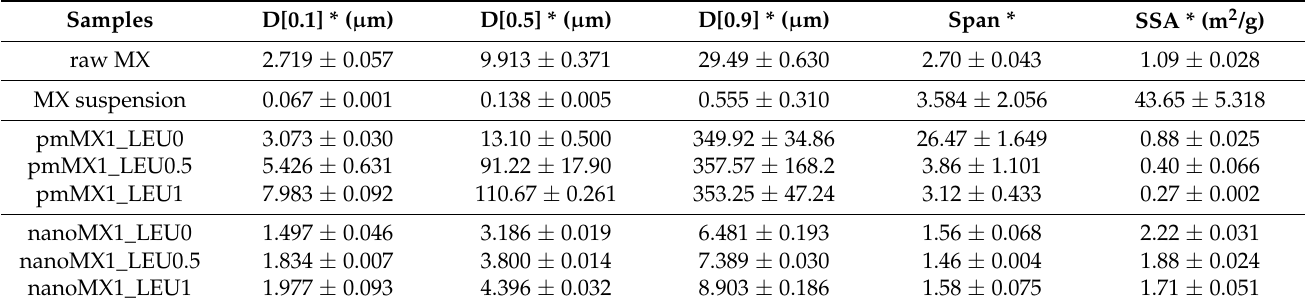
Table 4. Particle size of the initial active pharmaceutical ingredient (API), the nanosuspension, the physical mixtures, and the final samples. SSA, specific surface